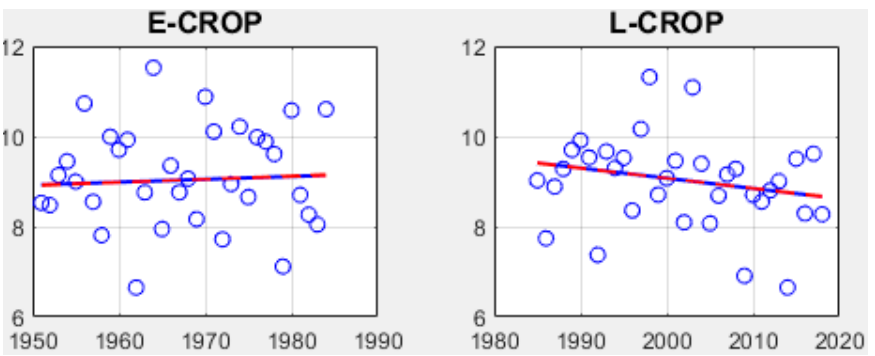
Figure 9. The date and line of the northern limit of the summer monsoon (climatological rainfall isochrones, orange lines) and area of land under rice crop production in each state (modified after [48]).